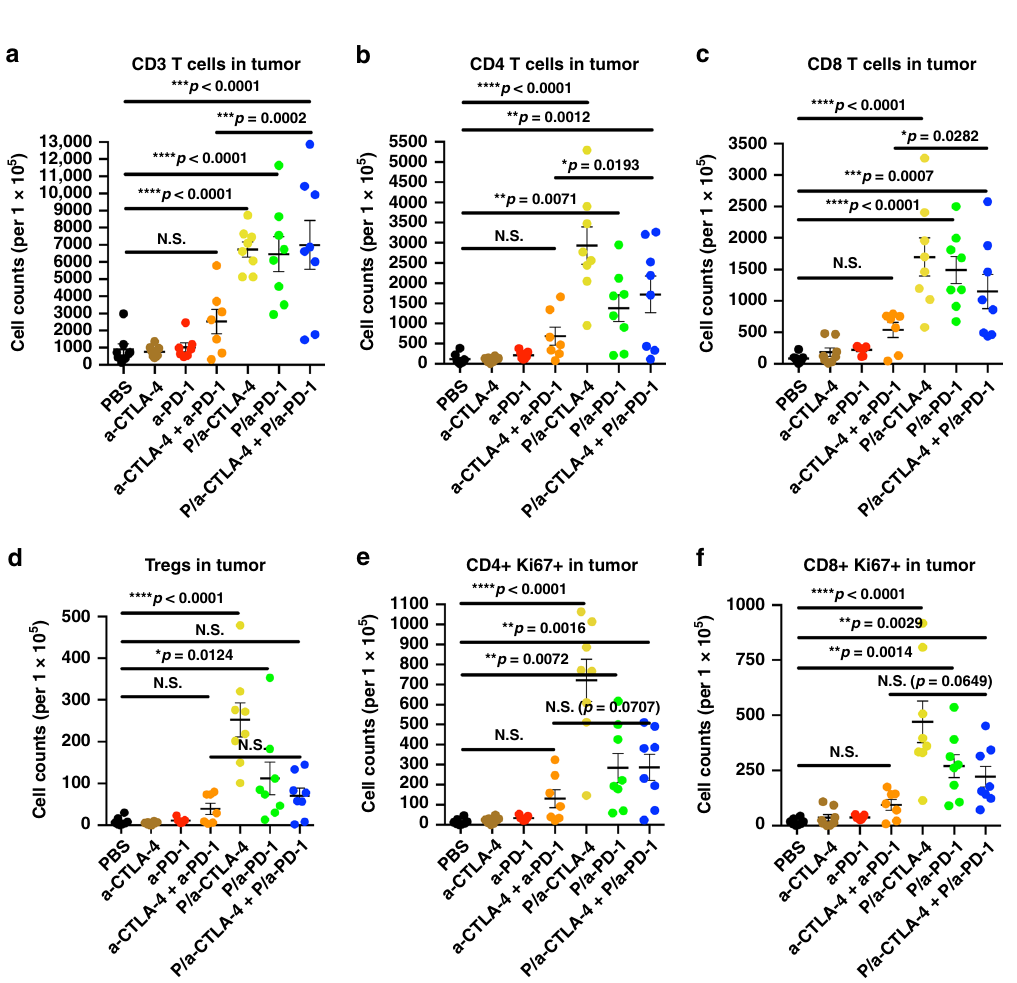
Fig. 3 Increase of tumor in fi ltrating T cells revealed by fl ow cytometry. GL261 brain tumors were analyzed by the spectral fl ow cytometry (SONY Biotechnology) and tumor-associated T cells are presented as the cell counts in each treatment group. a CD3 + T cells; b CD3 + CD4 + T helpers; c CD3 + CD8 + T effectors; d CD3 + CD4 + Foxp3 + Tregs; e Ki67 + proliferating CD4 + cells; f Ki67 + proliferating CD8 + cells. Approximately 100,000 events/ sample were recorded and analyzed by the SA3800 software (SONY Biotechnology). Data are mean ± SEM. * p < 0.05;. ** p < 0.01; *** p < 0.001; **** p < 0.0001; N.S. = non-signi fi cant (one-way ANOVA with Sidak ’ s posttest). N = 6 per